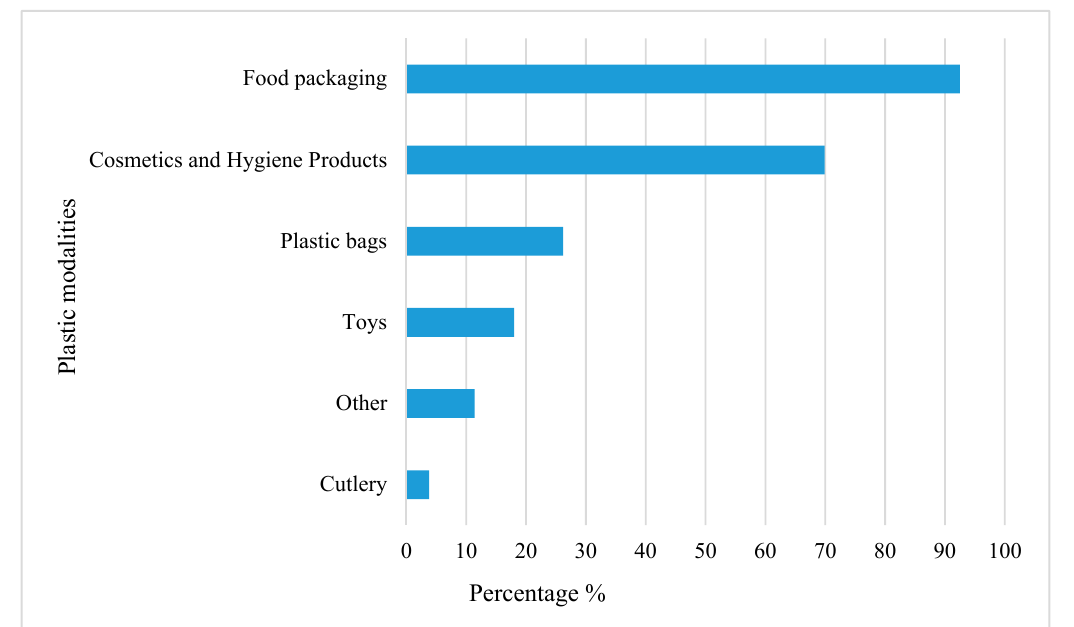
Figure 2. Assessment of plastic-based modalities used by European citizens derived from survey responses.